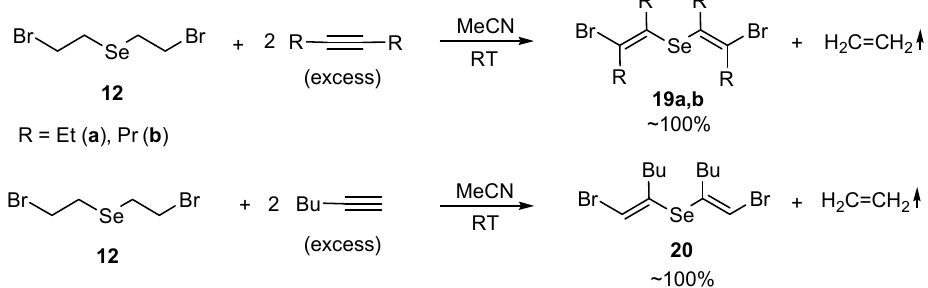
Figure 2. The 1 H-NMR monitoring of the 16b and 19b formation from selenide 12 in